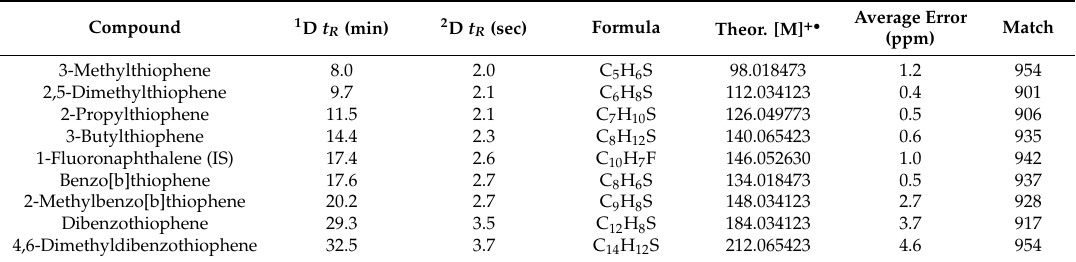
Table 1. Pure standard compounds, first and second dimension retention times ( t R ), molecular formula, theoretical [M] + • m / z value, average mass accuracy error, and HR ToFMS database